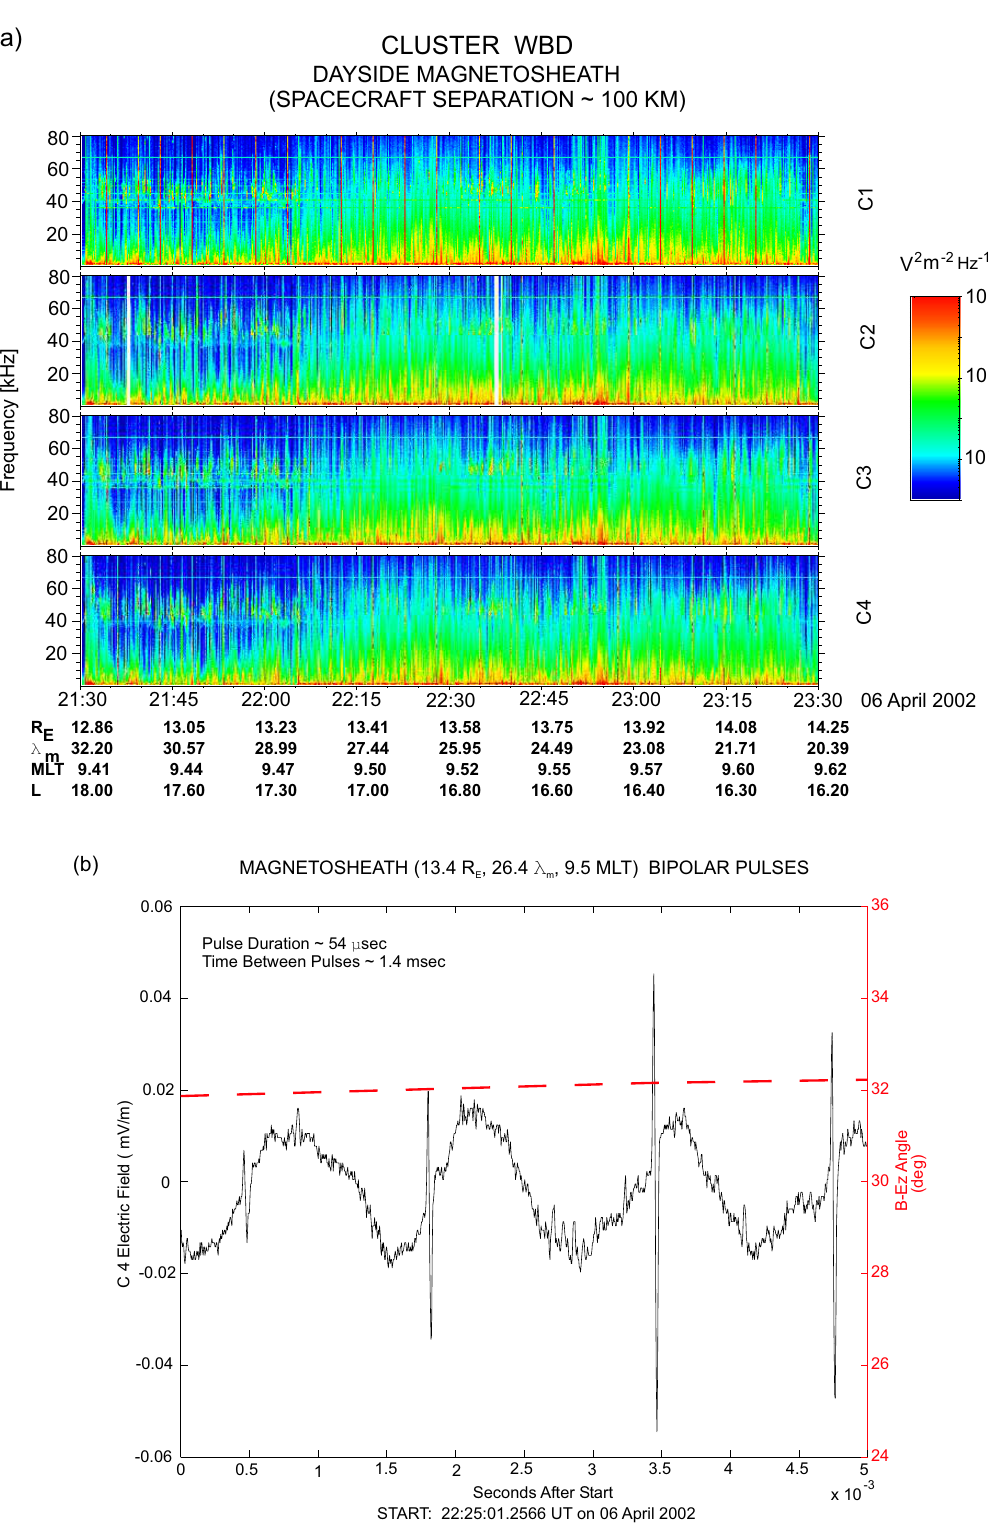
Fig. 2. Cluster WBD data taken on 6 April 2002 in the dayside magnetosheath. ( a ) Spectrogram showing the frequency and power spectral density of the emissions. The broad-band signals in this region, unlike the auroral zone, range in frequency from the lowest frequency measured up to 40–60kHz. ( b ) Representative bipolar pulse waveforms from a time of the broad-band signals, showing that the pulses are much shorter in duration in this region and that they are tied to a certain phase of the low frequency